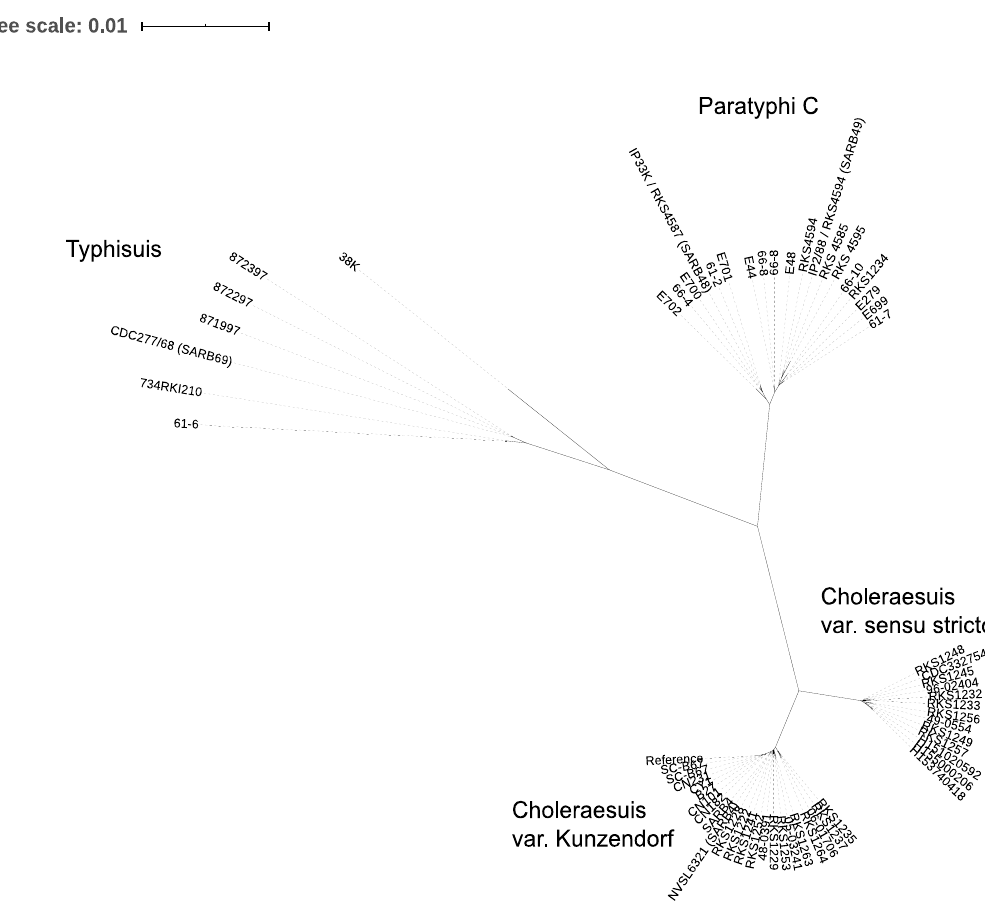
Figure 1. Phylogenetic clusters of 6,7:c:1,5 Salmonella. Unrooted core SNP phylogeny using S. Choleraesuis SC-B67 as a reference.